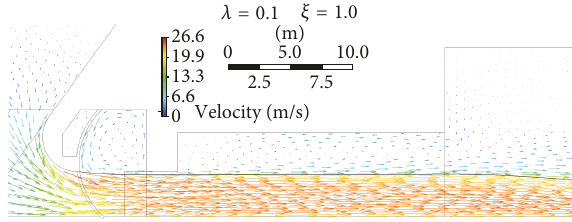
Figure 7: Steady-state air-water flow field at the full gate opening ( 𝜆 = 0.1, 𝜉 =